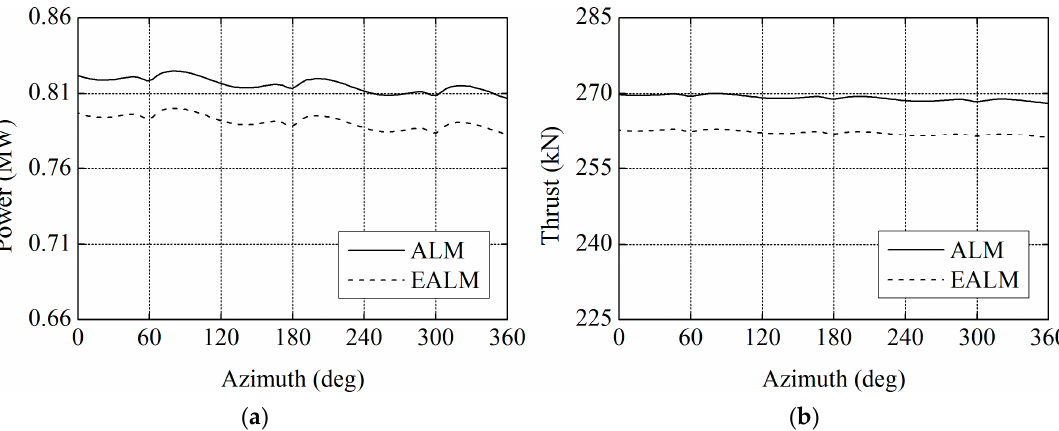
Figure 22. Comparison of downstream wind turbine aerodynamic performance results between Table 8. m/s: ( a ) power; and ( b ) thrust.